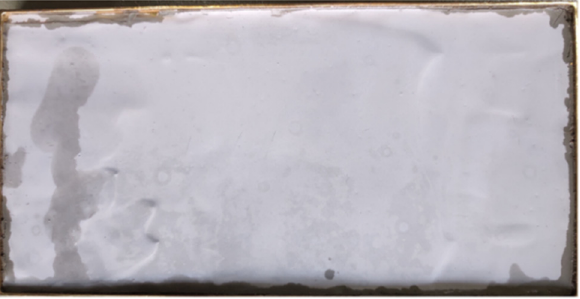
Figure 5. Morphology of the porous wick after pouring 72 h.